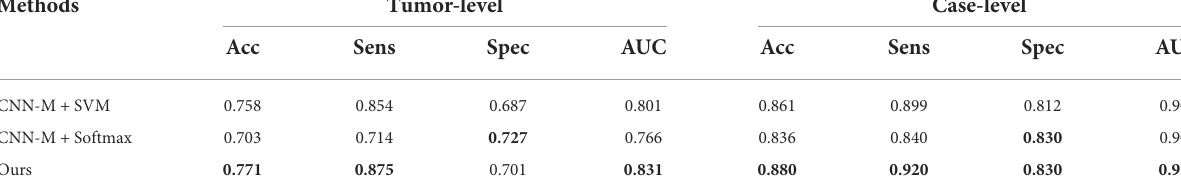
TABLE 5 Experimental results of the tumor-level and case-level